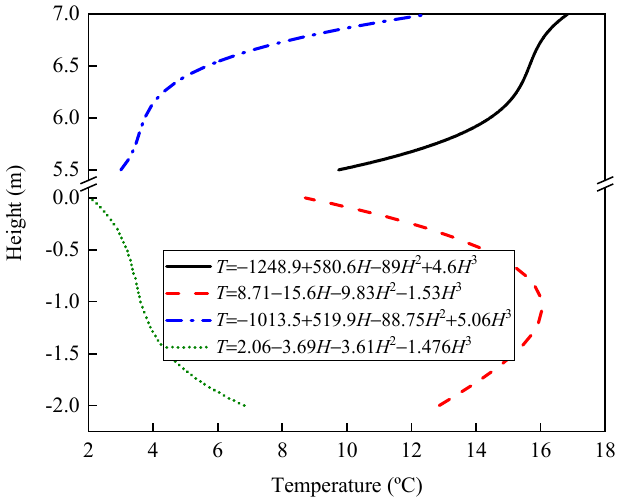
Figure 19. Fitted curves of temperature gradients of surfaces B and C in winter. A simplified critical temperature gradient in winter with a regular water level (5.05 m) is also provided in Figure 20. This temperature gradient is also obtained at 2 p.m. when the ambient air temperature is 1 ◦ C. The temperature gradient is the increment over ambient air temperature at that time.